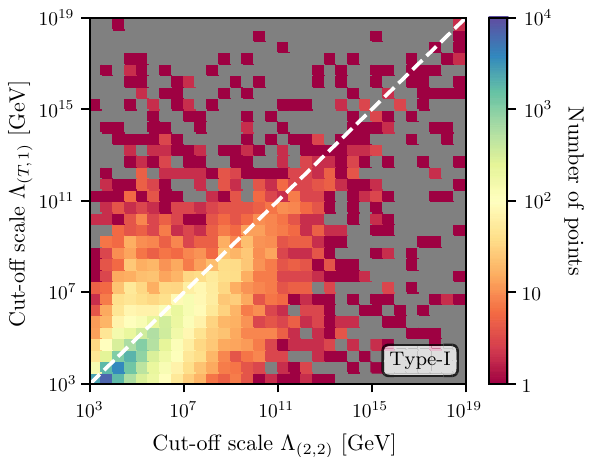
Fig. 8 Number of parameter points depending on the cut-off scale when including two-loop mass corrections and two-loop RGE running ( 2 , 2 ) aswellaswhendoingatree-levelmasscomputationandone-loop running ( T , 1 ) . Here we have applied the Yukawa scheme of type-I. The white line is the diagonal along (cid:10) ( T , 1 ) = (cid:10) ( 2 , 2 )